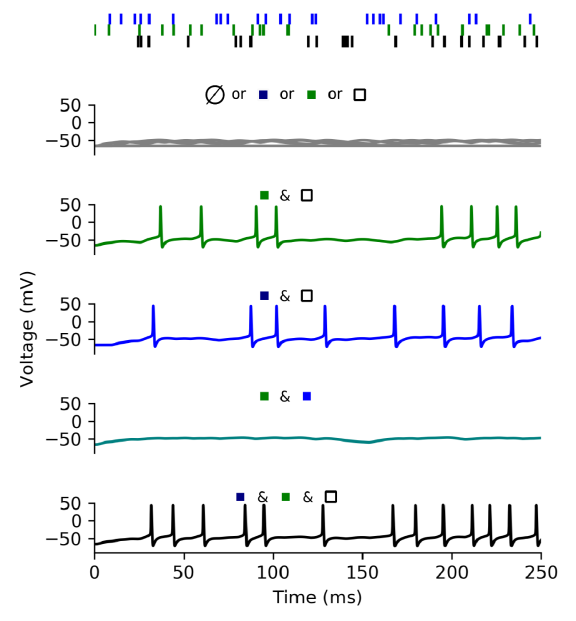
Figure 5. A biophysical model implementing the Dominant AND (rate interpretation). We show in this figure how the model presented in the previous figure responds in 8 different cases. X